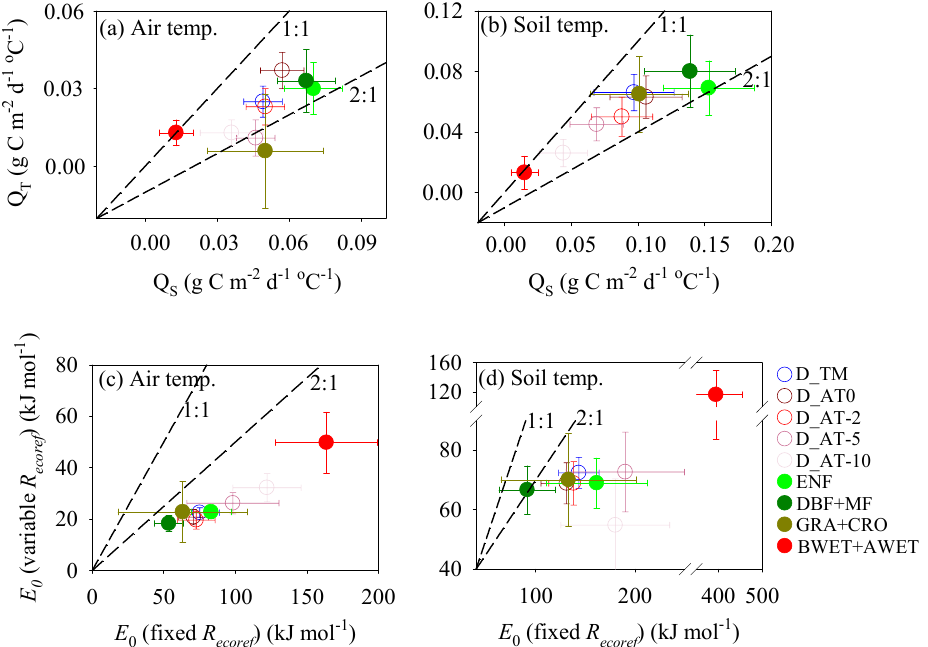
Fig. 3. The winter R eco sensitivity to temperature variation across space and the one over time is compared across different winter definitions and vegetation types, using both air (a) and soil (b) temperature, and two different types of winter R eco sensitivity to temperature variation across space calculated from the Arrhenius function are also compared using both air (c) and soil (d) temperature. The values from vegetation type are calculated according to winter definition D AT0.